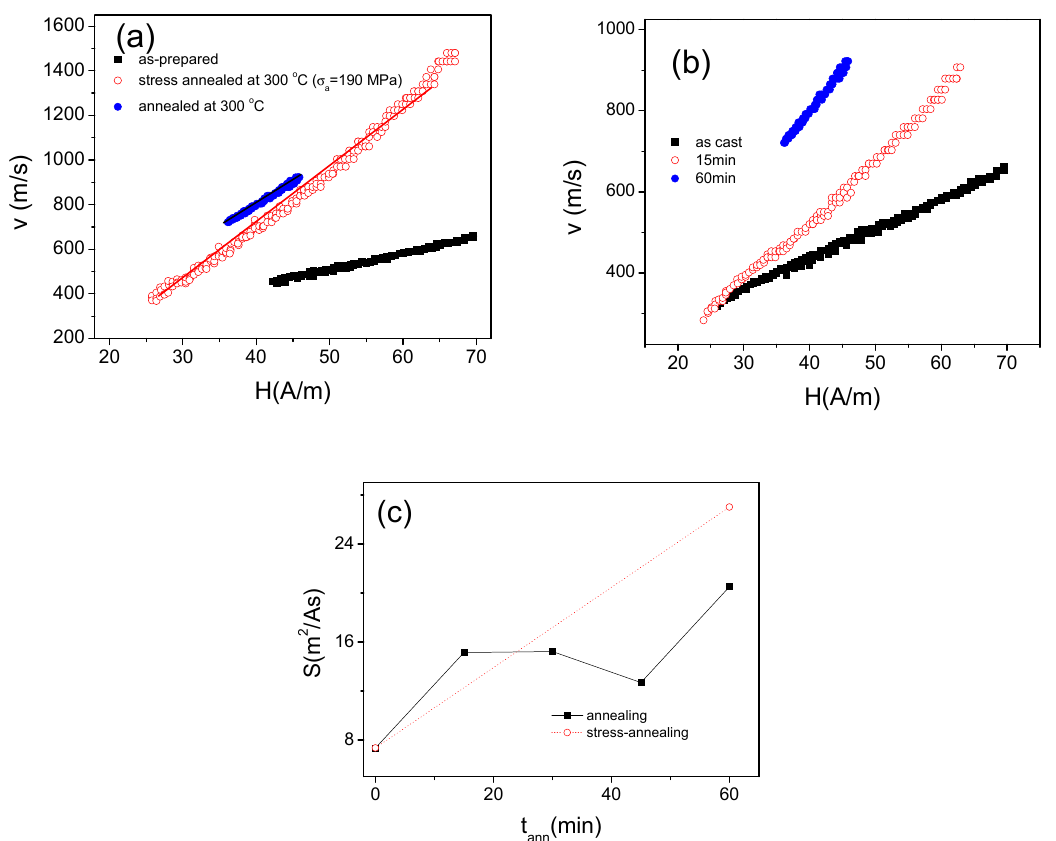
Figure 19. v ( H ) dependencies of as-prepared, annealed ( T ann = 300 °C) and stress- annealed at T ann = 300 °C for σ a =190 MPa ( a ) for as-prepared and annealed at T ann = 300 °C for different t ann ( b ) and effect of annealing conditions on S -value ( c ) of Fe 75 B 9 Si 12 C 4 microwires. The lines are just for eyes.